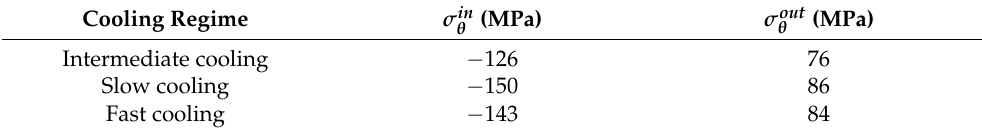
Table 4. Estimated residual stresses in fiber direction on the inside and outside surfaces of the